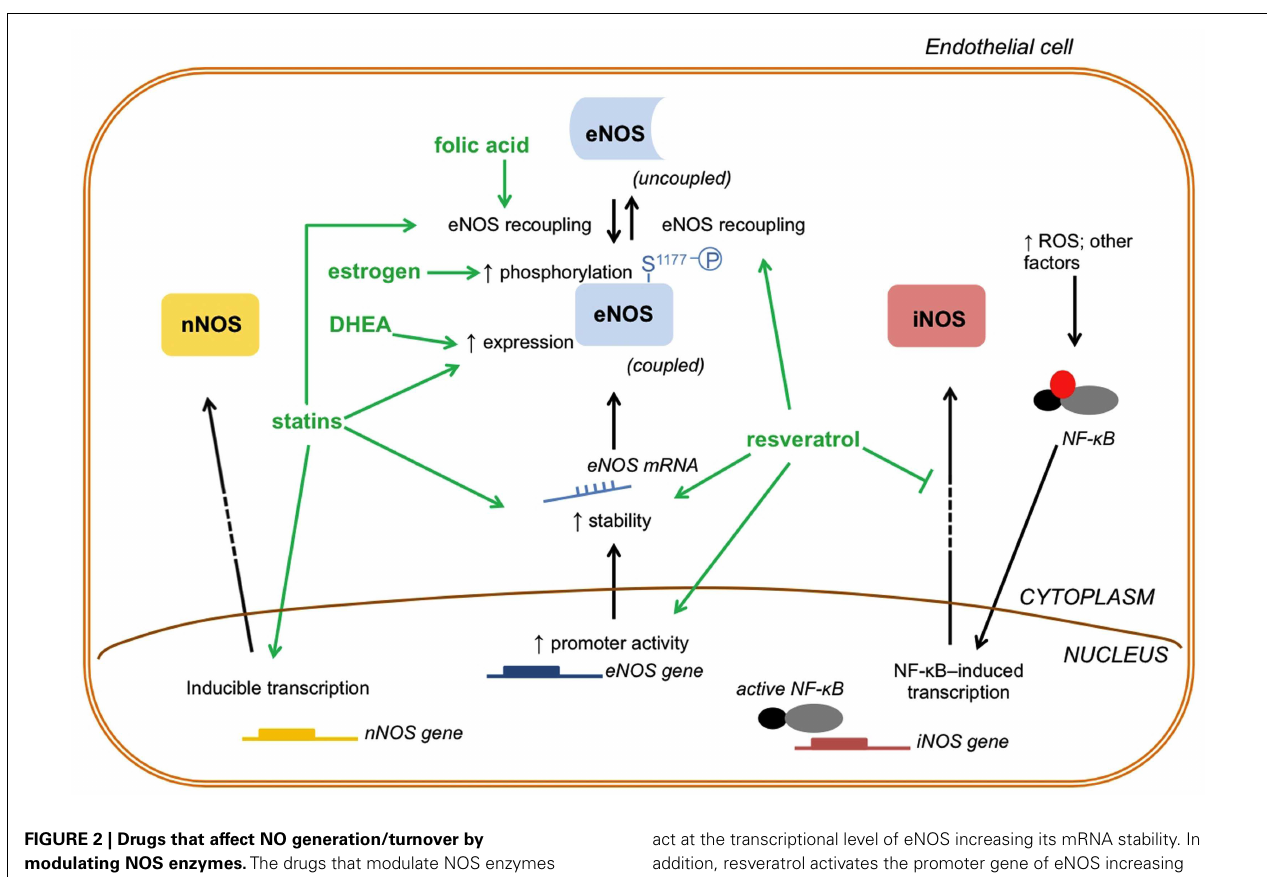
FIGURE 2 | Drugs that affect NO generation/turnover by modulating NOS enzymes. The drugs that modulate NOS enzymes and, consequently NO production, act by changing three important aspects of NOS enzymes function: activity, expression and transcription: (1) activity; estrogen induces eNOS phosphorylation at (S 1177 ) to increase enzyme activity; statins and folic acid may cause